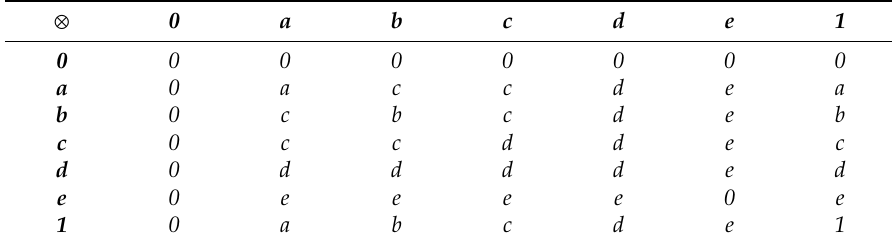
Table 14. The operation ⊗ on X .